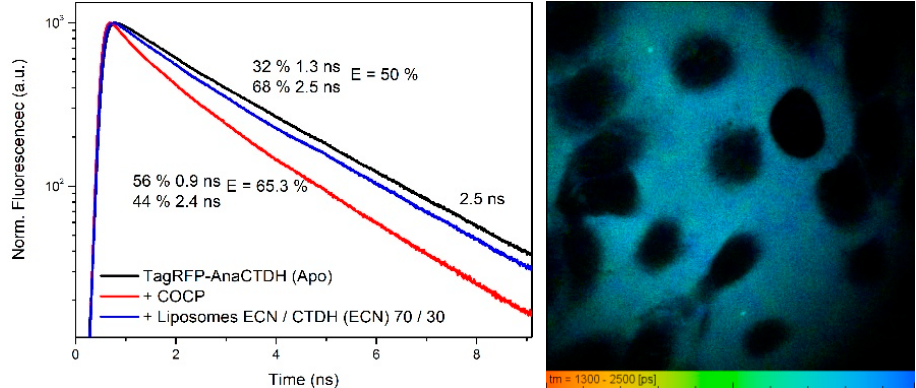
Figure A4. Left : fluorescence decay kinetics of the TagRFP-AnaCTDH chimera in the absence of carotenoid (black), after transfer of CAN from COCP (red) and after addition of liposomes (blue) which were previously enriched by ECN via the AnaCTDH(ECN) holoprotein. Right : FLIM image of HeLa cells with the TagRFP-AnaCTDH chimera showing no signs of colocalization of the protein at the membranes.